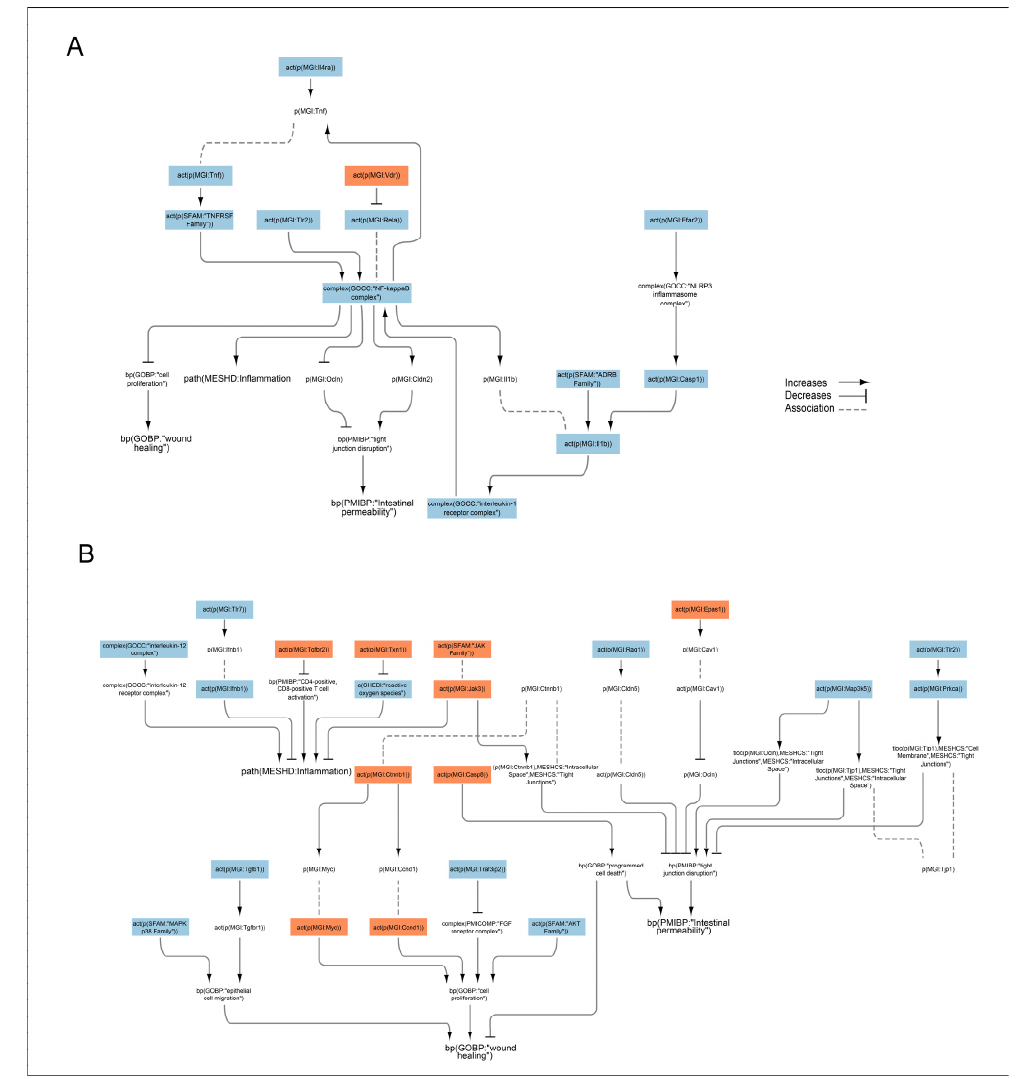
Figure 6. Signaling pathways impacted by nicotine in the DSS-treated humanized mouse colon. The subgraph extracted from the merged IBD network model [34] shows the nodes that were inferred to be regulated with an adjusted p < 0.05 when scored with comparative transcriptomic data from nicotine + DSS vs. DSS-treated mouse colon. ( A ) Pathways regulating nuclear factor- κ -light-chain-enhancer of activated B cells (NF- κ B) complex. ( B ) Other pathways beside NF- κ B inferred to be regulated by nicotine and leading to intestinal permeability, wound healing, and inflammation. The directionalities are shown as orange or blue bars for inferred upregulation or downregulation, respectively. The BEL (biological expression language) terms [37,38] are as follows: act, protein activity; p, protein abun- dance; bp, biological process; tloc, translocation. MGI is the namespace for mouse proteins, GOCC is the namespace for protein complexes, MESHCS is the namespace for cell structures, MESHD is the namespace for diseases, and SFAM and PMIBP are custom namespaces for protein families and bio- logical processes, respectively. ADRB, adrenoceptor beta; Ctnnb, beta catenin; Casp, caspase; CCnd1, Cyclin D1; Cldn, claudin; Epas, endothelial PAS domain protein; Ffar2, the free fatty acid receptor; Ifn, interferon; Il, interleukin; Jak, Janus kinase; Map3k5, mitogen-activated protein kinase 5; MAPKp38; p38 mitogen-activated protein kinase; NF-kappaB, nuclear factor kappa-light-chain-enhancer of acti- vated B-cell complex; NLRP3, NLR family pyrin domain containing 3; Ocln, occludin, Prkc, protein kinase C; Rag, recombination activating; Tgfb, transforming growth factor beta receptor; Tjp, tight junction protein; Tlr, Toll-like receptor; Tnf, tumor necrosis factor; TNFRSF, TNF receptor superfamily; Traf3ip2, Traf3 interacting protein; Txn, thioredoxin; Vdr, vitamin D